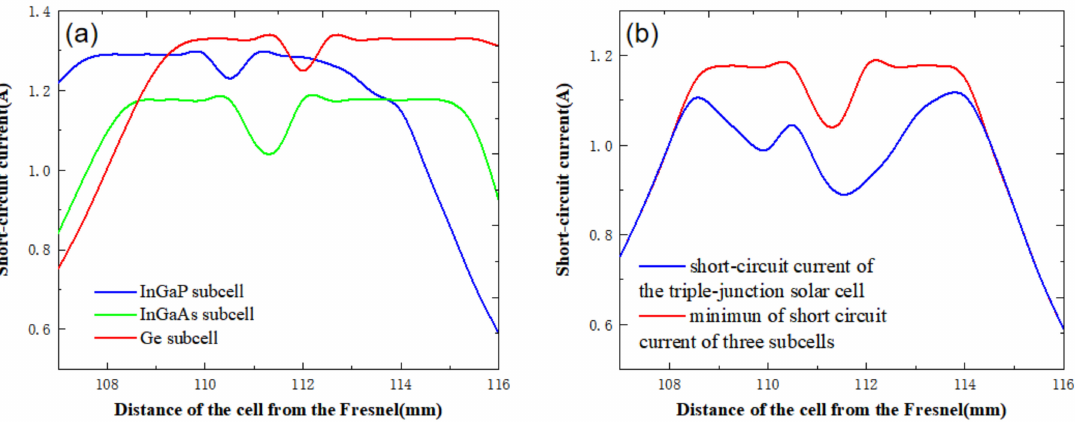
Figure 9. ( a ) Short-circuit current of three sub cells; ( b ) Minimum short-circuit current of sub cells and short-circuit current of triple-junction solar